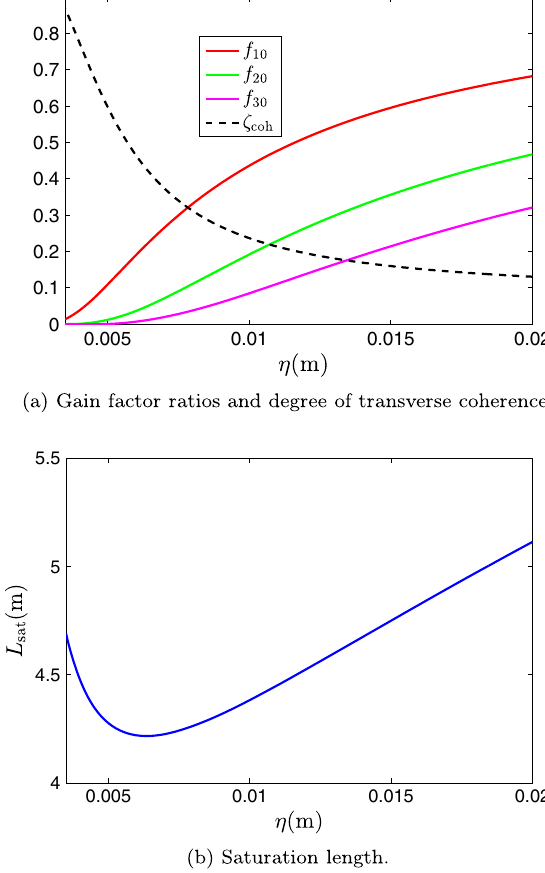
FIG. 7. Gain factor ratios, degree of transverse coherence (calculated using modes of the form m 0 , with 0 ≤ m ≤ 4 ) and saturation length as a function of the dispersion (data from the analytical